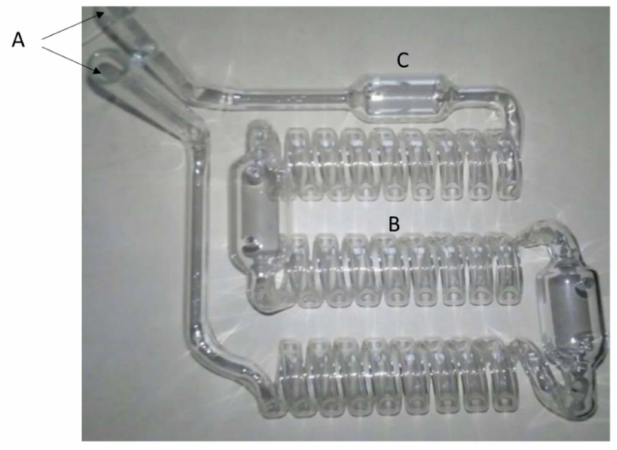
Figure 3. Fabricated coiling glass pipe with A : Input-Output. B : Coiling. C : Bulbs used to install optical fiber